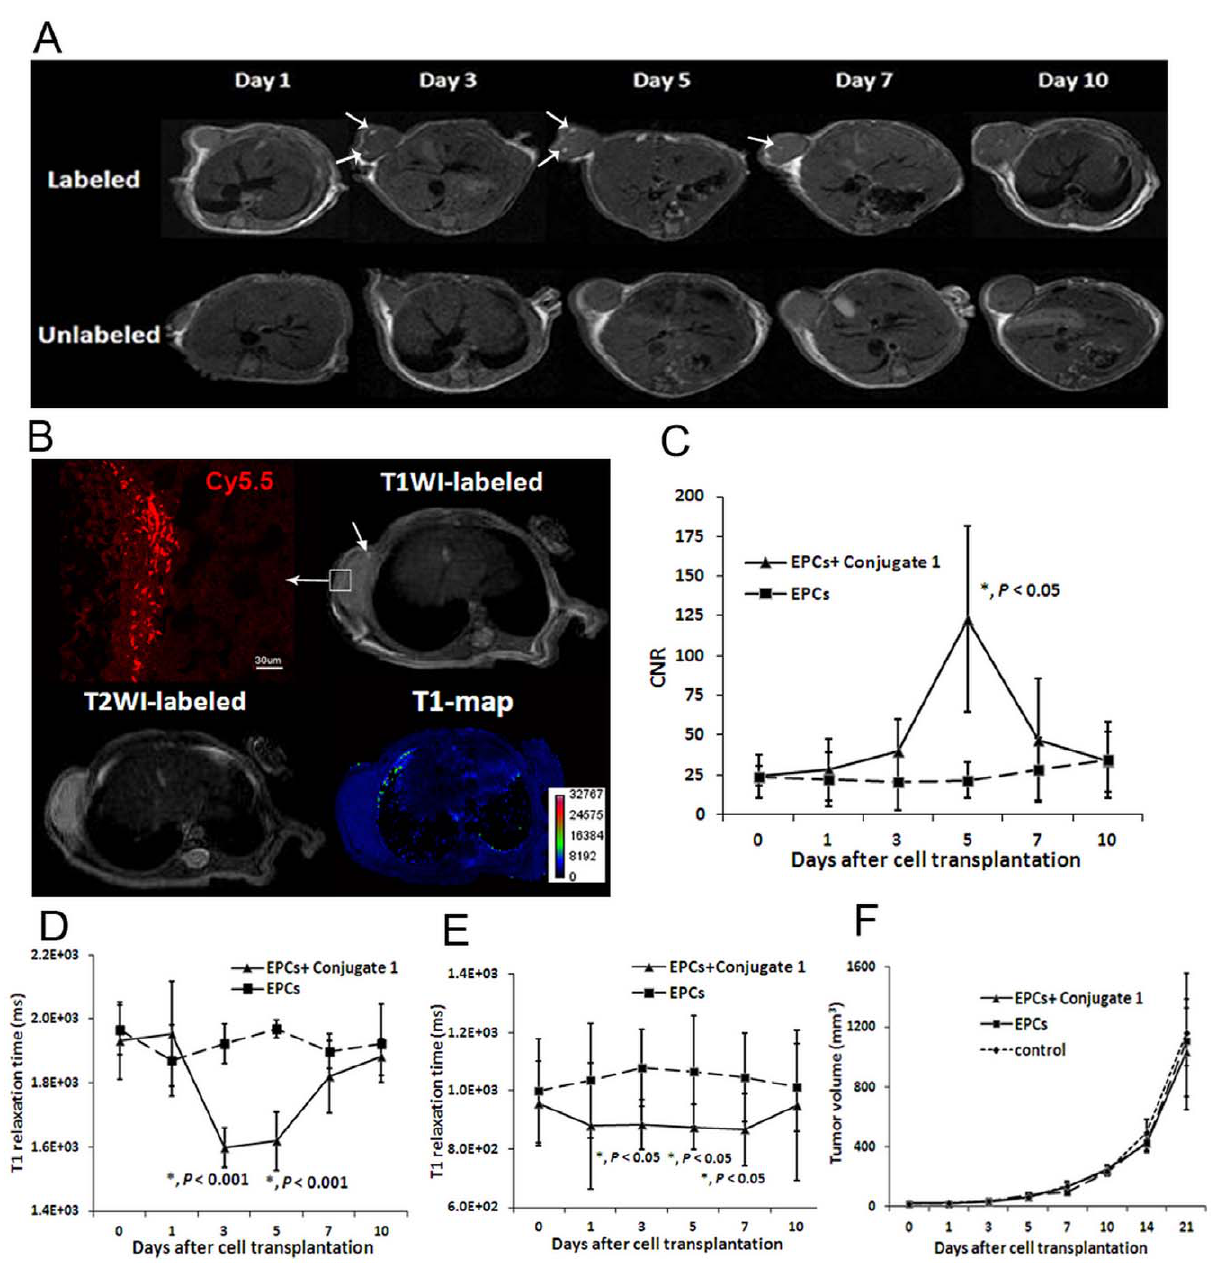
Figure 2. MRI exams demonstrated the homing of labeled EPCs into tumors. (A) Sprinkles of hyperintense region at the margin of the tumor ( arrows ) on T 1 -weighted images indicate the presence of Conjugate 1 labeled EPCs in the tumor as early as 3 days after transplantation. Significant hyperintense areas within the tumor were also observed at day 5 and day 7. (B) A representative T 1 -weighted image, T 2 -weighted image and pseudo-color T 1 map obtained at day 5. Images of fluorescent microscopy showed that Cy5.5 positive cells were found at the corresponding areas of high signal intensity ( arrows ) on T 1 -weighted images. Scale bar=30 m m (C) The CNR from the region of interest of group 1 reached the maximum at day 5. The difference between group 1 and 2 in CNR was statistically significant ( p , 0.05, n =3). (D) Coinciding with the signal enhancement detected from T 1 -weighted images, intratumoral T 1 relaxation time initially decreased to (1.60 6 0.06) 6 10 3 ms at day 3 and persisted at (1.62 6 0.09) 6 10 3 ms until day 5. The mean value recovered to the base line two days later. The significant decrease of T 1 relaxation time ( p , 0.001, n =3) confirmed the homing property of transplanted EPCs. (E) Although the accumulation of Conjugate 1 labeled EPCs in the liver did not induce significant contrast enhancement, a significant decrease of hepatic T 1 relaxation time was observed from day 3 to day 7 ( p , 0.05, n =3). (F) During the three weeks of monitoring period, no significant difference in tumor volume was found between each group at each time point ( p . 0.05, n =3). doi:10.1371/journal.pone.0050575.g002 For microvessel density quantification, CD31 positive micro- number of microvessels increased significantly in both groups vessels were counted at 7, 14 and 21 days after cell transplantation. (from 97.99 6 27.47 and 110.77 6 15.47/mm 2 at day 14 to Tumors in group 1 and 3 had similar MVD at day 7 (72.43 6 17.44 177.99 6 19.11 and 163.31 6 25.66/mm 2 at day 21). However, and 68.17 6 12.79/mm 2 , respectively). As tumors grew, the